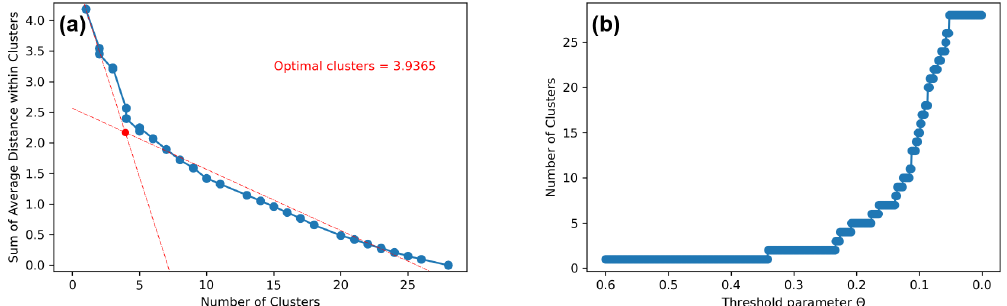
Figure 4. Determination of optimal clustering threshold θ for N. America during July–September 2014. (a) Sum of averaged distance E ( θ ) as a function of the number of clusters (blue). Two linear regressions (red) are added. The intersection (red dot) gives the optimal number of clusters. (b) Variation of the number of clusters with θ .